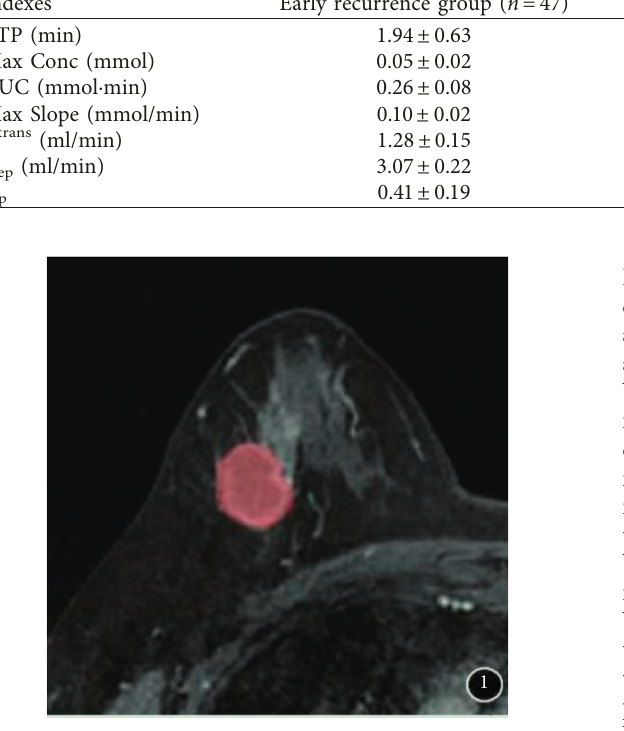
Figure 1: Morphological features of phase 3 DCE-MRI in late recurrence group.